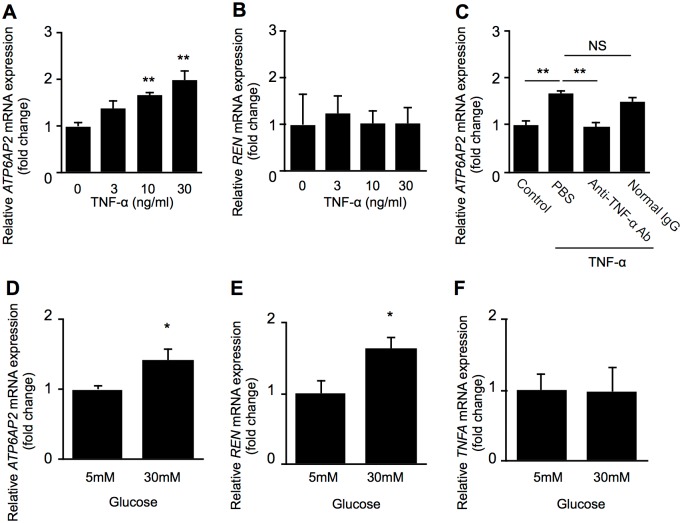
TNF-α- and glucose-induced expression of RAS initiators in retinal vascular endothelial cells.(A, B) ATP6AP2 and REN mRNA expression levels in HRMECs stimulated by inflammatory mediators. After serum starvation, HRMECs were treated with recombinant human TNF-α (0, 3, 10 and 30 ng/ml) for 24 hours and processed for analysis to detect mRNA expression levels of ATP6AP2 (A) and REN (B). n = 6, **p < 0.01, Student’s t test. (C) For TNF-α neutralization bioassay, recombinant human TNF-α at 10 ng/ml was pre-incubated with 200 ng/ml of rabbit anti-TNF-α neutralizing antibody. n = 6, **p < 0.01, Student’s t test. (D-F) HRMECs were incubated with the medium containing 30-mM glucose for 72 h, and ATP6AP2 (D), REN (E) and TNFA (F) gene expression levels were analyzed. n = 6, *p < 0.05, Student’s t test.